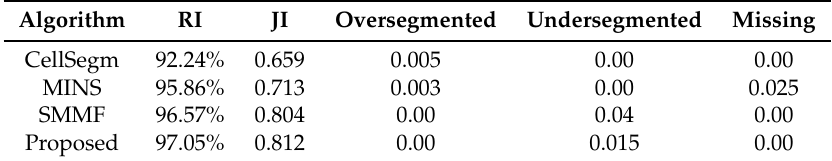
Table 1. A comparison of the quality of segmentation on 30 simulated HL-60 cell line images. The values in the quality index are average values over the 30 datasets. In terms of RI and JI, SMMF and the proposed method demonstrate reasonable performance values compared to MINS and CellSegm.